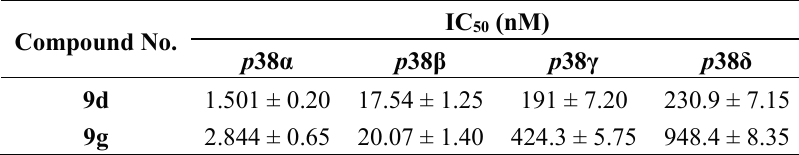
Table 2. Kinase selectivity assay of selected compounds ( 9d , 9g